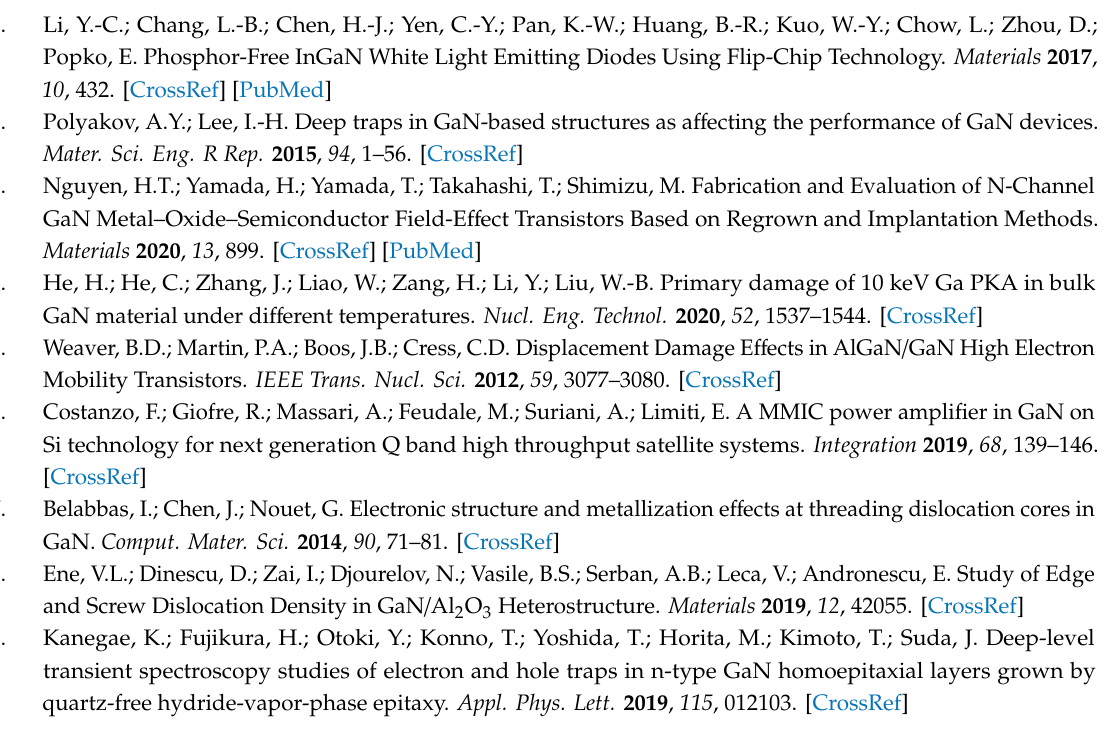
Figure A3. Configurations of B 3 type split interstitial: ( a ) side view and ( b ) top view.